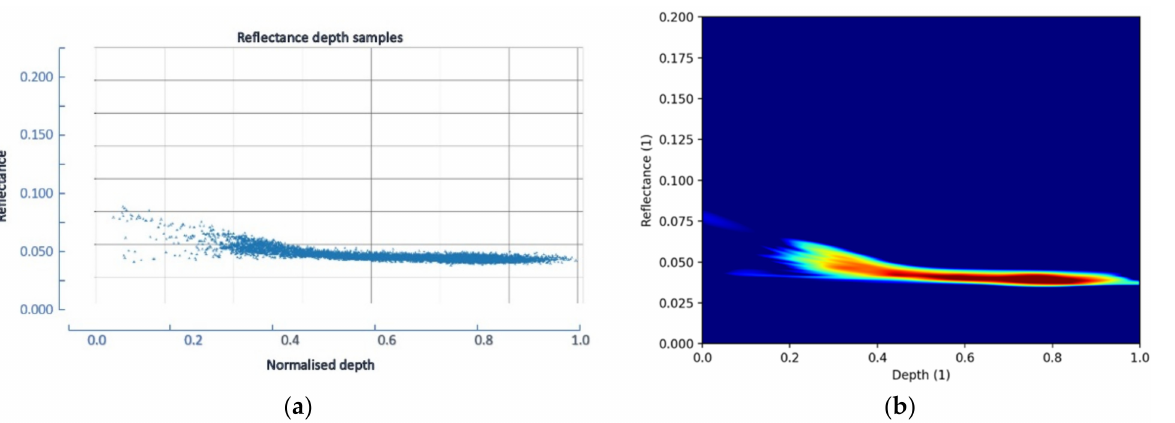
Figure 26. ( a ) Pleiades’ reflectances/depths plot; ( b ) WCPE density plot after training. Note the very homogeneous, almost linear environment